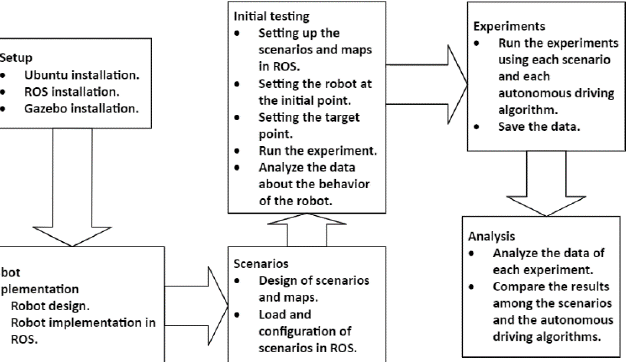
Figure 5. The methodology used for the development and implementation of the platform and virtual scenarios.